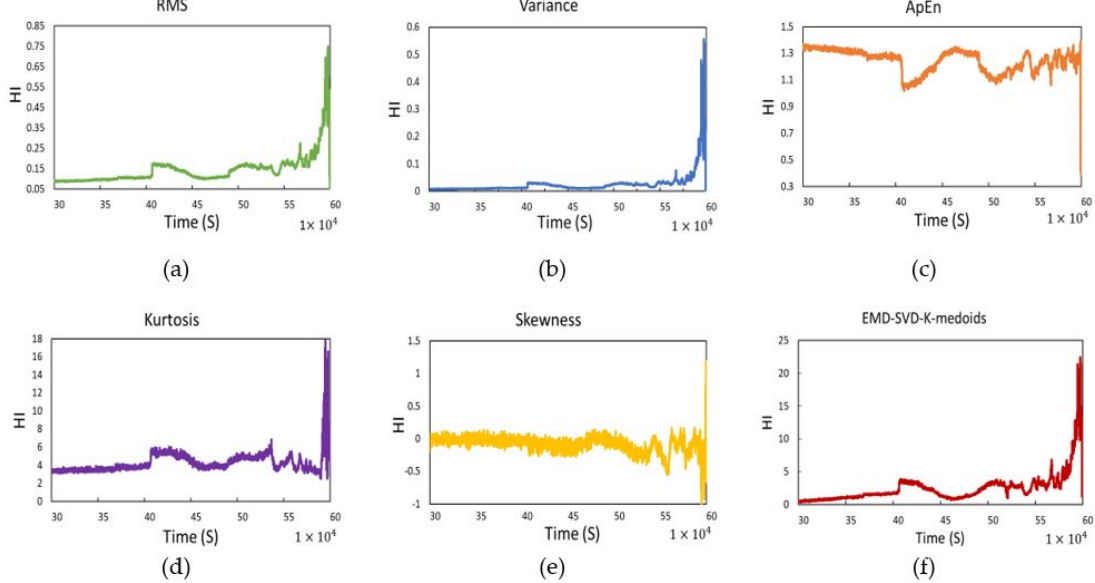
Figure11. Constructed HI invariousmethods: ( a )rootmeansquare(RMS),( b )variance, ( c )approximate Figure 11. Constructed 𝐻𝐼 in various methods: ( a ) root mean square (RMS), ( b ) variance, ( c ) entropy (ApEn), ( d ) kurtosis, ( e ) skewness, and ( f ) approximate entropy (ApEn), ( d ) kurtosis, ( e ) skewness, and ( f ) EMS-SVD-K-medoids.